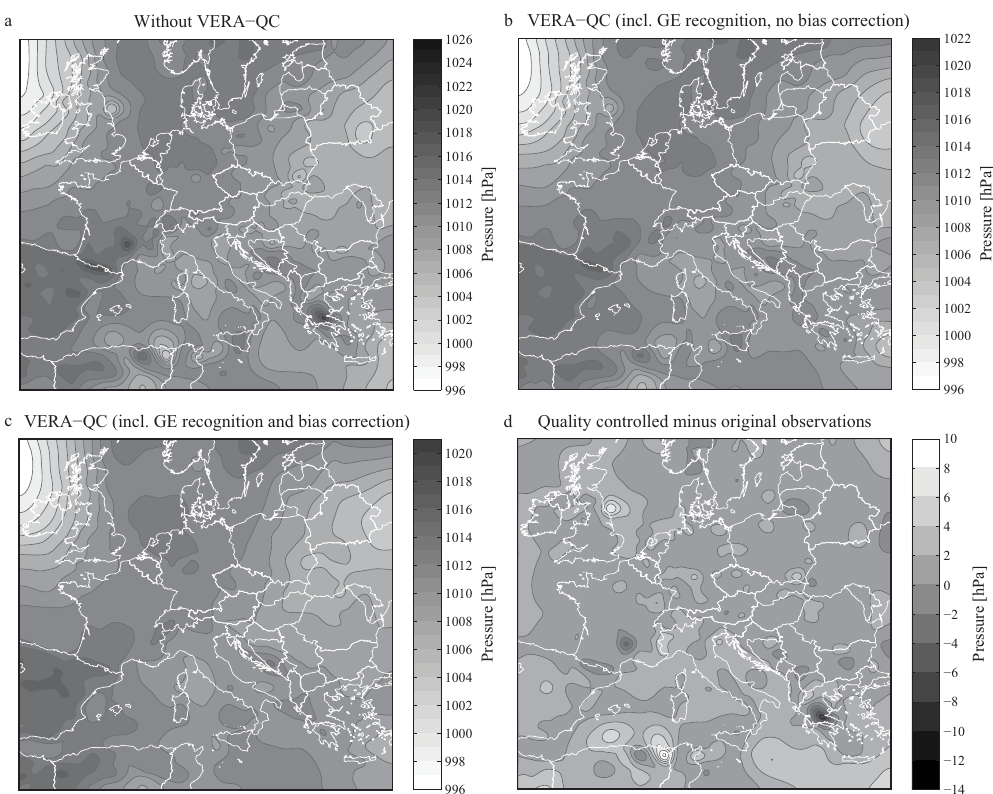
Fig. 10. Illustration of how observations are gradually improved by the VERA-QC. For all four figures, the values at the station positions in the European domain are interpolated to a regular grid by the analysis tool VERA. (a) Shows the original MSL-pressure values, computed from the 1567 observations on 5 July 2011, 06:00UTC. (b) Presents the quality controlled observations, however no bias correction was applied. An amount of 0.89% of all observations are identified as gross errors and thus are excluded from the analysis. (c) Shows the results after applying the complete QC (with bias correction). The amount of gross errors is reduced to 0.38%. Finally, in (d) the differences between the quality controlled and original observations are